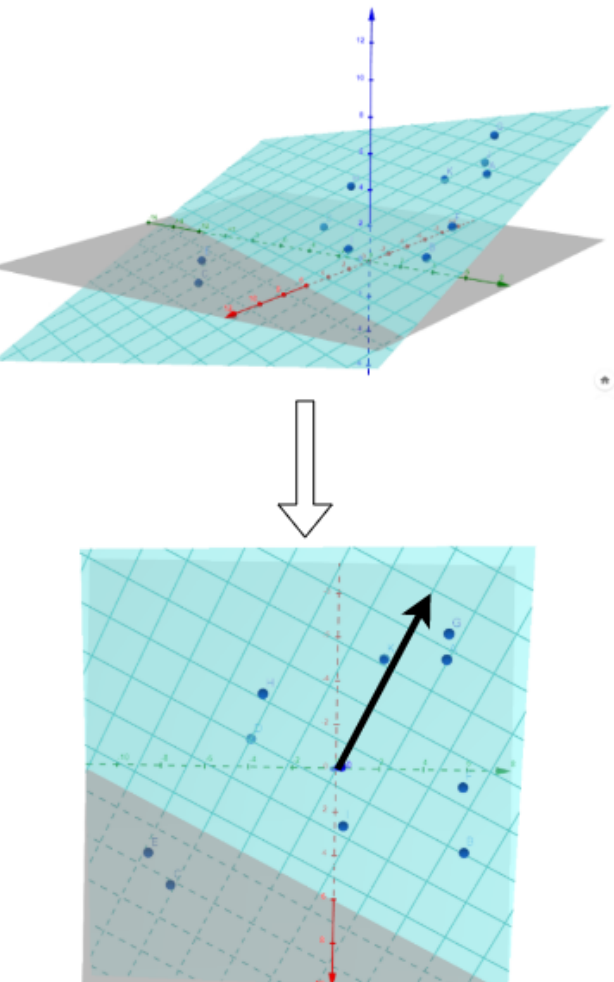
Figure 3. Gradient of the hyperplane corresponding to the greatest